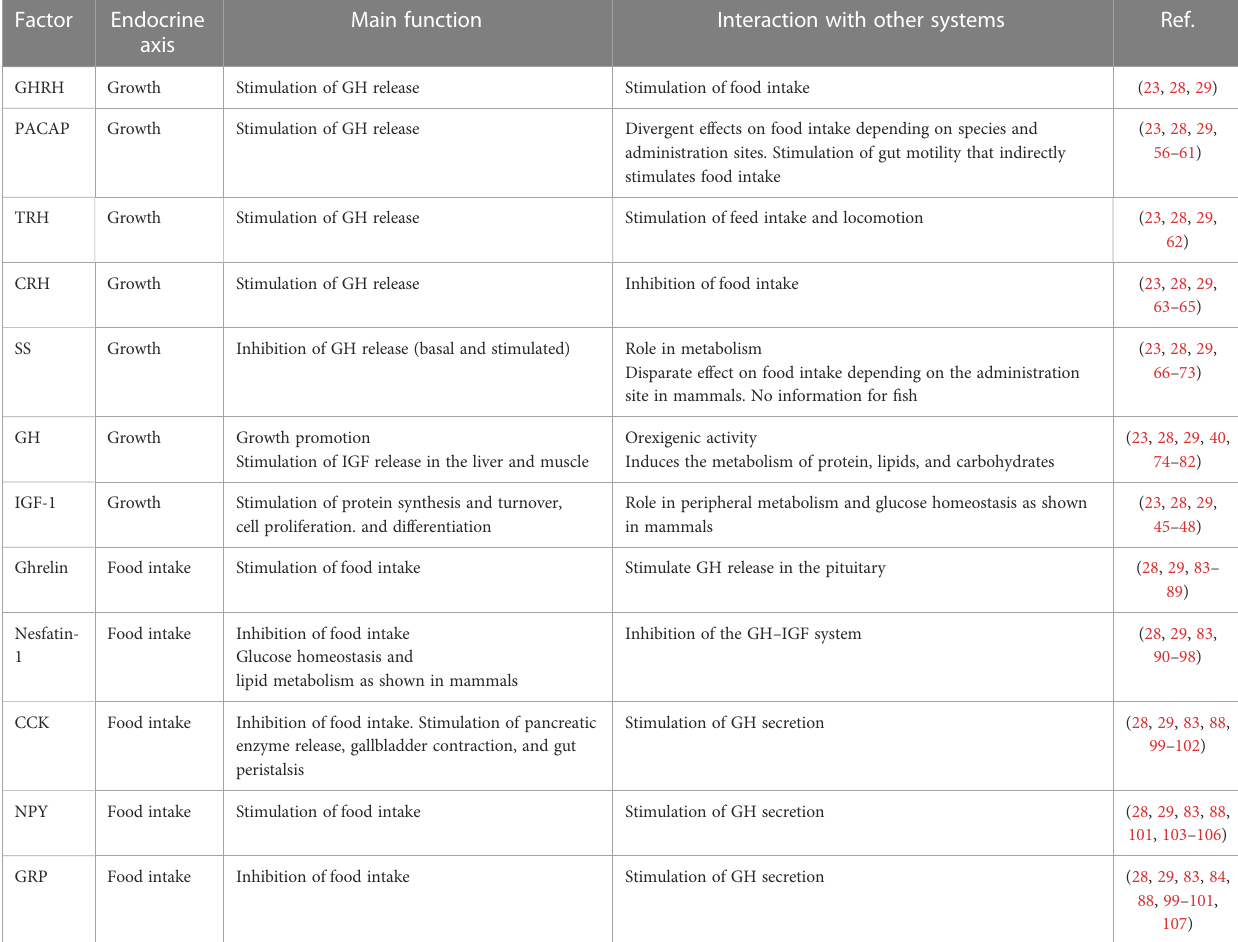
TABLE 1 Summary of interacting factors linking growth and food intake in fi